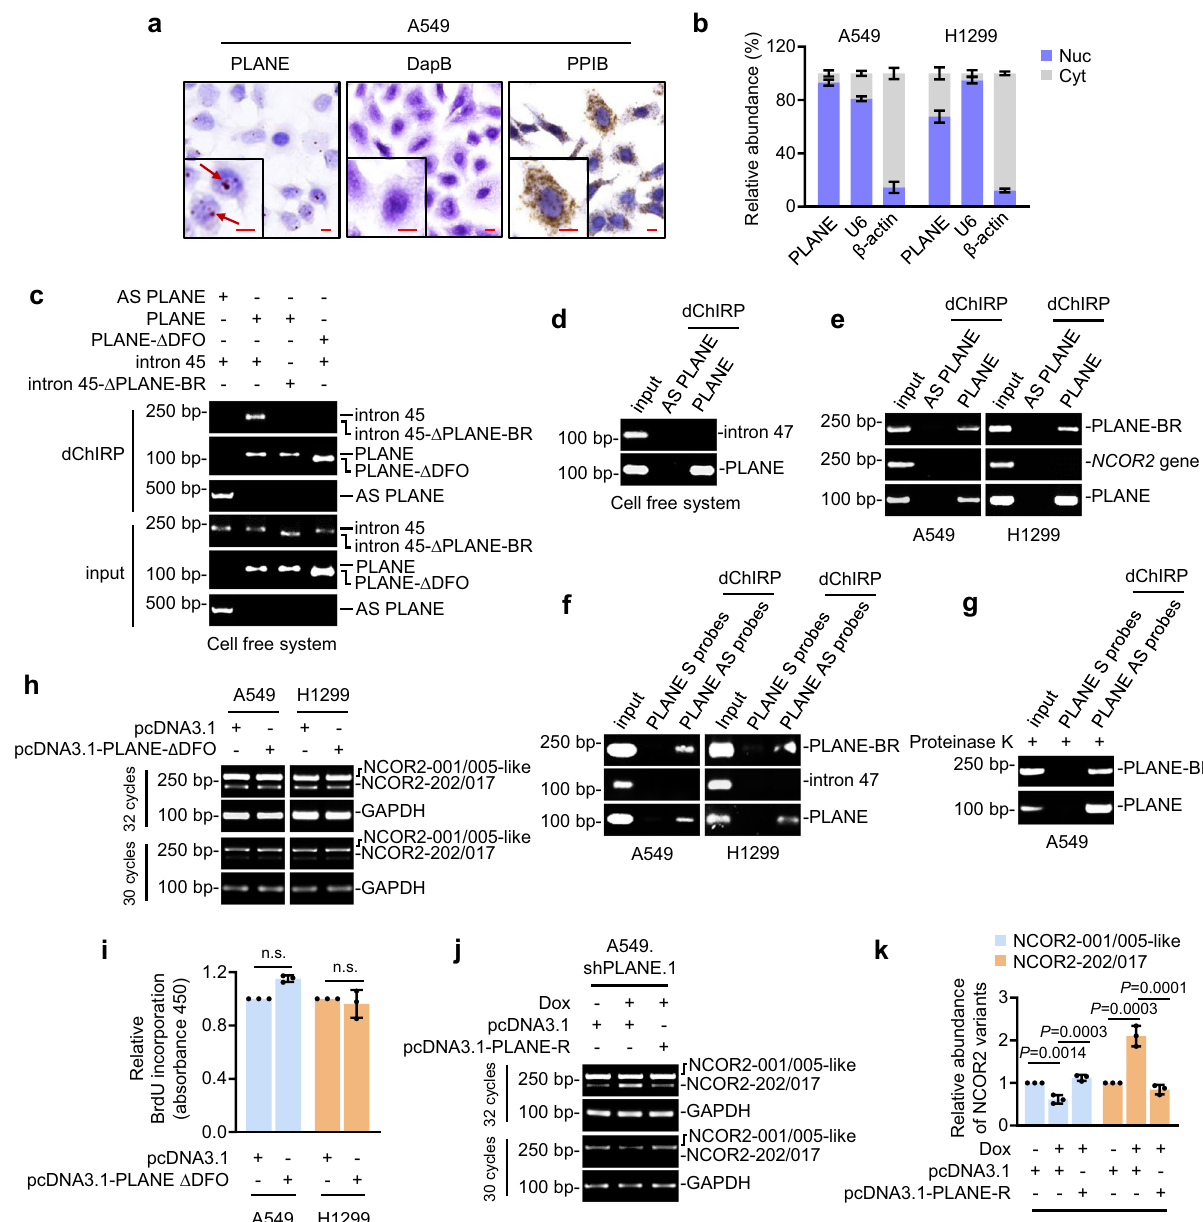
Fig. 4 PLANE forms an RNA – RNA duplex with the NCOR2 pre-mRNA. a Representative microphotographs of in situ hybridization (ISH) analysis of PLANE expression. DapB: negative control; PPIB: positive control. Scale bar, 10 µ m. Data are representatives of 3 independent experiments. b qPCR analysis showing PLANE subcellular localization. Cyt: cytoplasm; Nuc: nucleus. β -actin: Cyt marker; U6: Nuc marker. Data are mean ± s.d.; n = 3